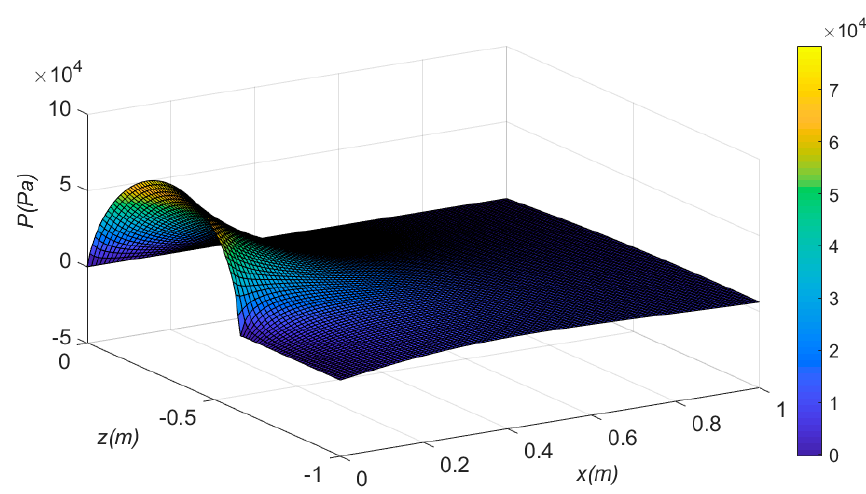
Figure 7. Hydrodynamic pressure distributions in the liquid field for v = 300 and fixed air cavity position − 1 ≤ z cavity ≤ − 0.6 at t = 0.01 s .